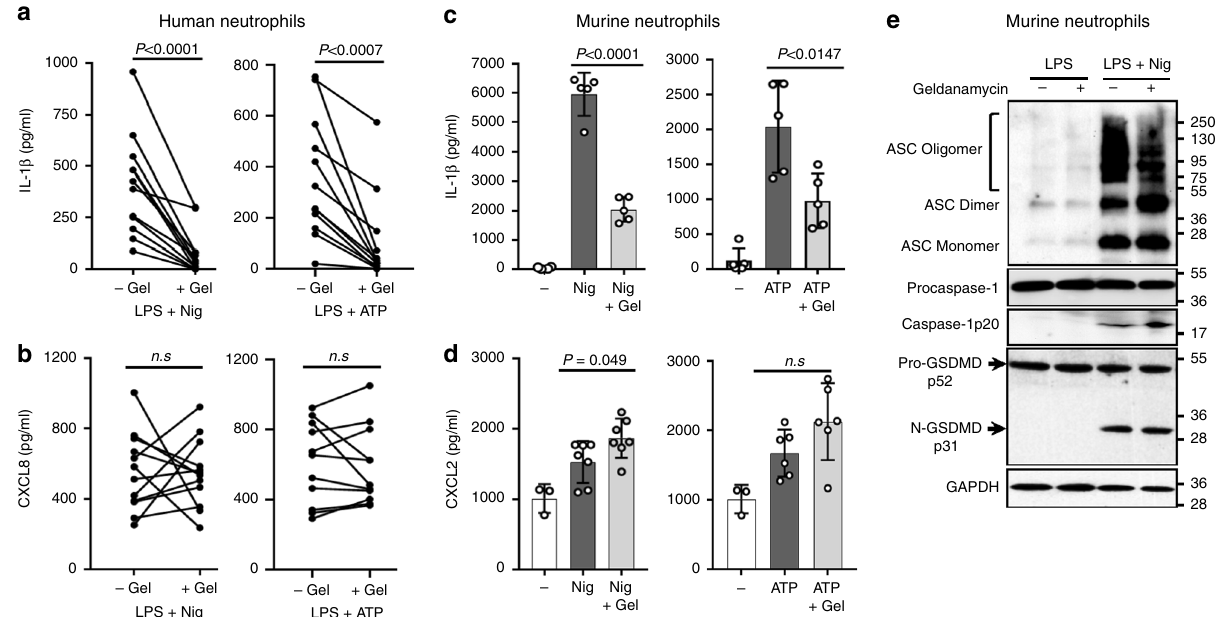
Fig. 6 Geldanamycin inhibition of NLRP3 in fl ammasome-induced IL-1 β release. a – d Human peripheral blood neutrophils ( n = 12 donors) or bone marrow neutrophils from C57BL/6 mice were LPS primed (3 h), followed by 45 min stimulation with nigericin or ATP in the presence or absence of the HSP-90 inhibitor geldanamycin (Gel, 10 μ M). Secretion of IL-1 β ( a , c ), CXCL8 ( b ), or CXCL2 ( d ) was quanti fi ed by ELISA. e Western blots of ASC oligomers, caspase-1 and GSDMD from LPS/nigericin-stimulated murine bone marrow neutrophils ±10 μ M geldanamycin. Western blot data are representative of 3 independent experiments. Molecular weight markers in kDa are indicated on the right. For human neutrophils, each data point represents 1 donor and p -values were based on paired t tests from 12 donors ( n = 12). For murine neutrophils, means±SD from at least 5 independent experiments are shown as individual data points ( n = 5). p -values for murine neutrophils were derived by unpaired t test using Tukey post analysis; p < 0.05: signi fi cant, n.s.: not signi fi cant. Source data for all western blots in panel e are provided as uncropped blots in Supplementary Information, Supplementary Fig. 19. Source data for panels a , c , b , d are provided in the separate Source Data fi le.